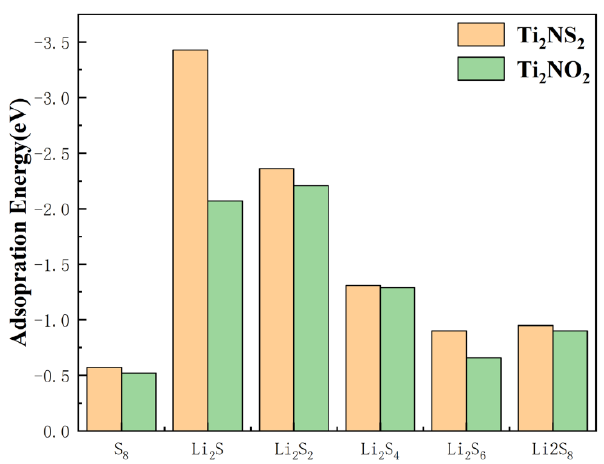
Figure 6. Adsorption energies of Ti 2 NS 2 and Ti 2 NO 2 .